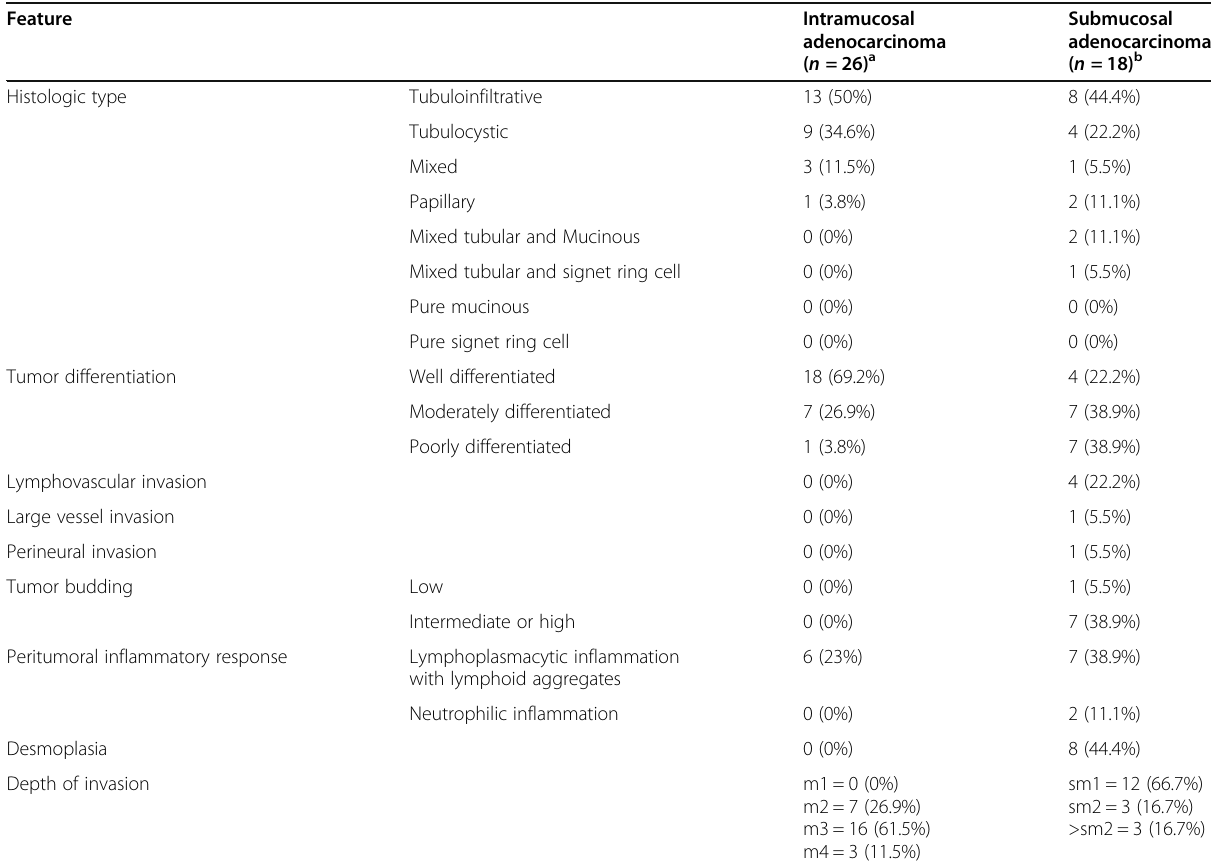
Table 2 Histologic features of intramucosal and submucosal adenocarcinoma Feature